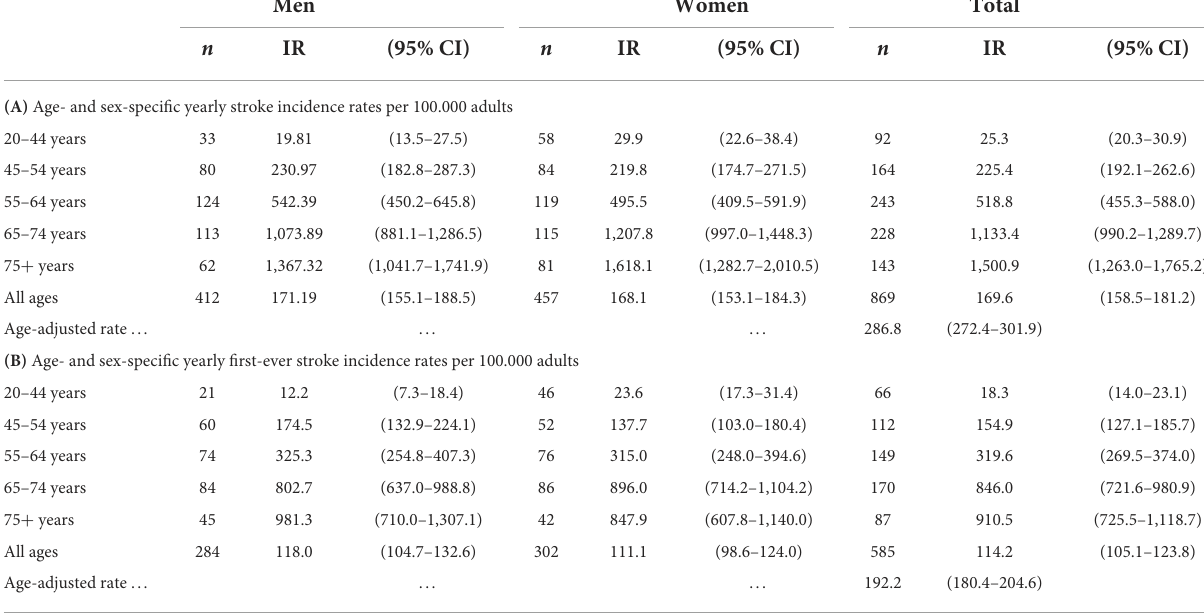
TABLE 1 Age- and sex-specific yearly incidence rates (IR) per 100.000 adults for (A) any stroke and (B) first-ever stroke standardized to the WHO world adult